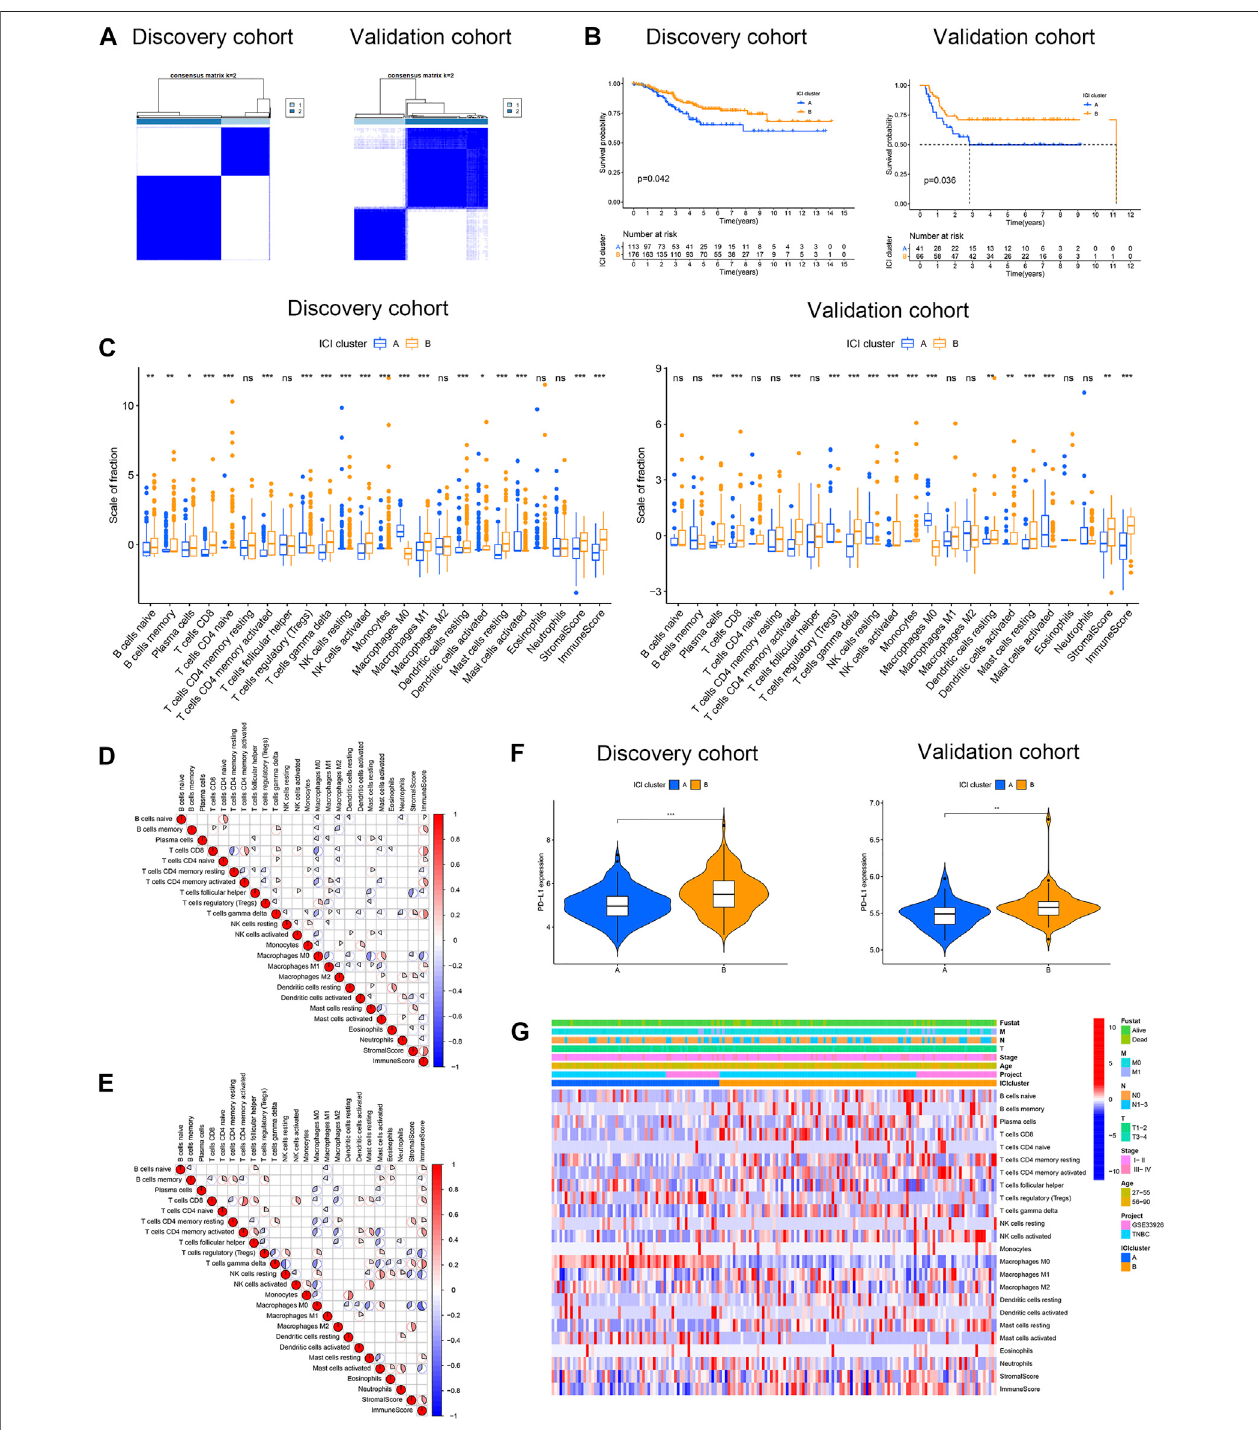
FIGURE 1 | Characterization of ICI in two cohorts of TNBC. (A) Two independent ICI subtypes were determined through the ConsensusClusterPlus R package in thediscoveryandvalidationcohorts. (B) OScurvesoftwoICIsubtypesintwocohorts.Thelog-ranktestshowed p =0.042and p =0.036inthediscoveryandvalidation cohorts. (C) Estimation of the fraction of 22 immune cells, as well as immune and stromal scores in ICI clusters A and B of two cohorts (D,E) Interaction of 22 immune cells, as well as immune and stromal scores, in the discovery cohort (D) and validation cohort (E) . (F) Different PD-L1 levels between ICI clusters A and B in two cohorts. (G) Unsupervised clustering of ICI with distinct clinical phenotypes in TCGA-TNBC and GSE33926 datasets. * p < 0.05; ** p < 0.01; *** p < 0.001; and **** p < 0.0001.